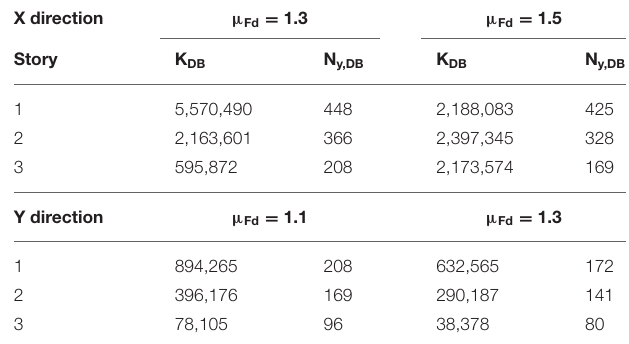
TABLE 3B | Stiffness (kN/m) and strength (kN) of the HYDBs (case A, CP limit state). X direction µ Fd = 1.3